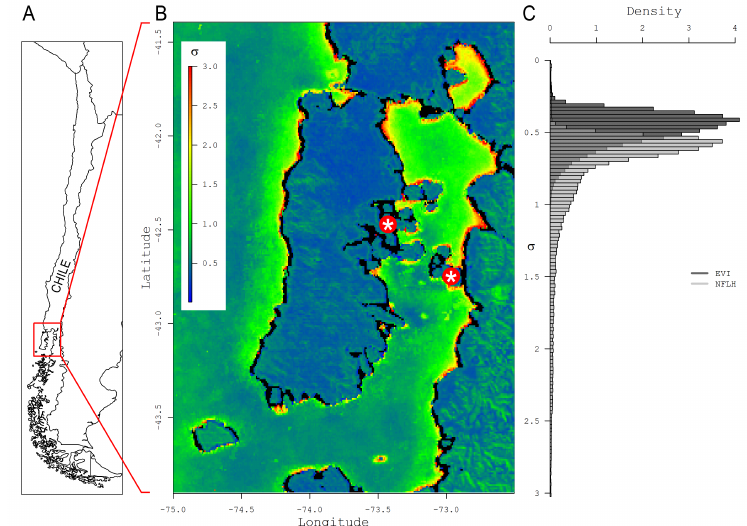
Figure 1. Study area: ( A ) Study area showing its location along the coast of Chile. ( B ) northern–Patagonia Ecosystem coloured using the standard deviation of Enhanced Vegetation Index (land) and normalized fluorescence line height (water) from all available images over the 2003–2017 study period. ( C ) Histogram of the standard deviation in EVI (black) and nFLH (gray). The full temporal series of images (2003 to 2017, for EVI and nFLH) was used to calculate one single image that contained the variability of both measurements. First, every image was standardized to work with both sets in the same units, using − mean ( X ) the formula x . For EVI, the image was re-sampled to 1km, to match the resolution of nFLH. sd ( X ) Then, for every stack of images (EVI and nFLH), the standard deviation of every pixel trough time is calculated and a single image is generated for every product. Both images, the standard deviation for EVI and nFLH, are added in order to fill the land/water that both products do not cover. In all points where they overlap (coastal zones) the values were filled with null values. The main axis of Desertores Islands, are denoted by red